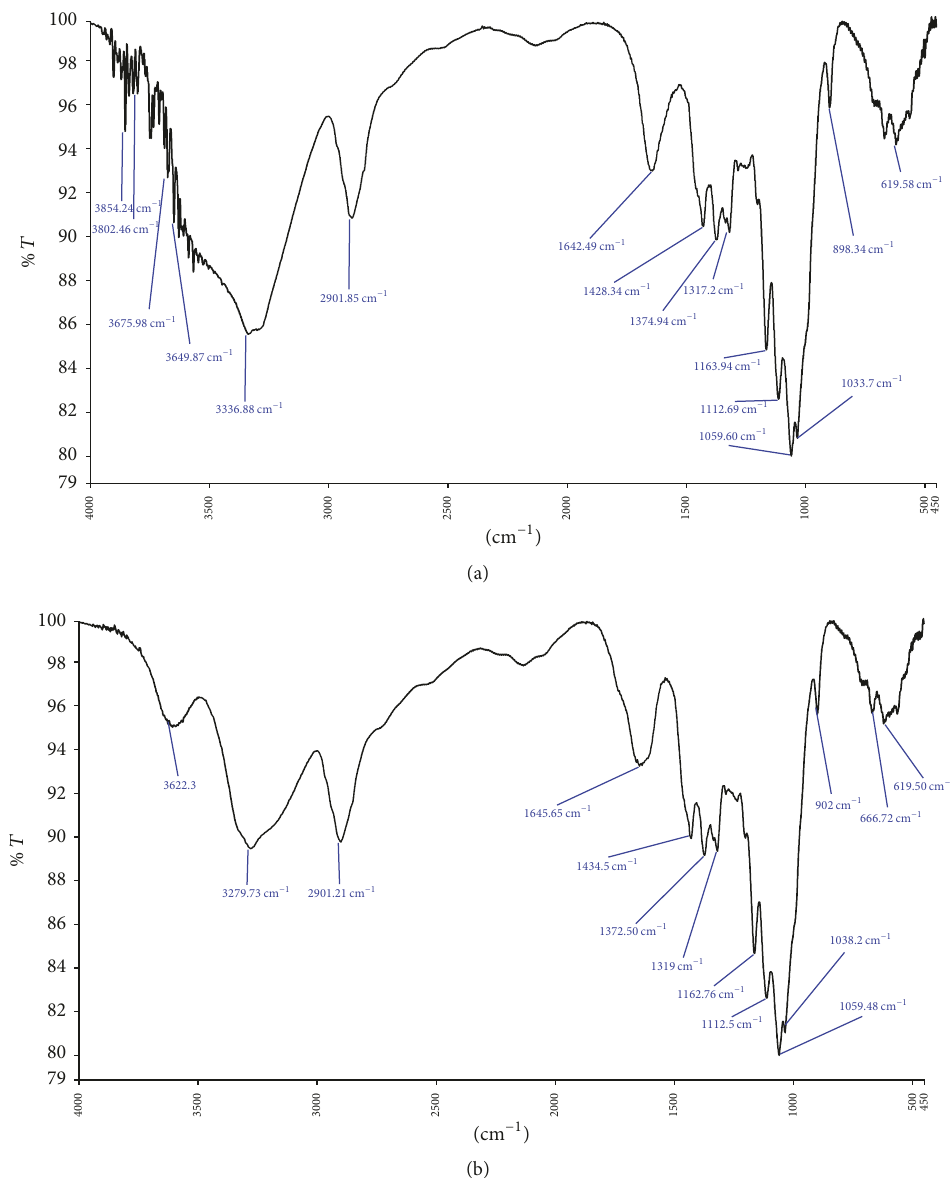
Figure 3: The FTIR spectrum of the cellulose extracted from rice straw without ultrasound (a) and using the ultrasound-assisted alkaline extraction method